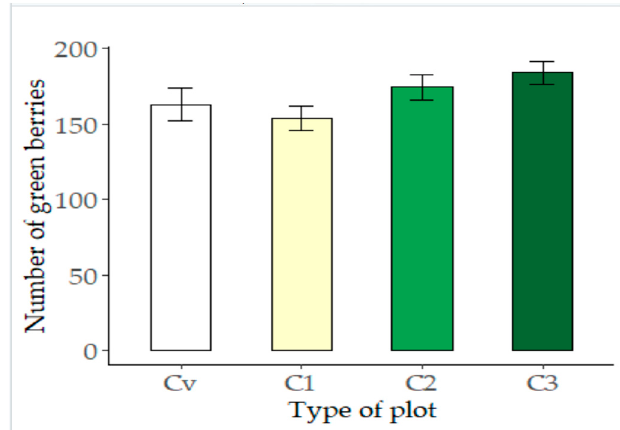
Figure 7. Number of green berries per cluster, counted in plots conducted in conventional production (Cv), first, second or third year of conversion to organic farming (C1 to C3). Mean ± standard deviation.